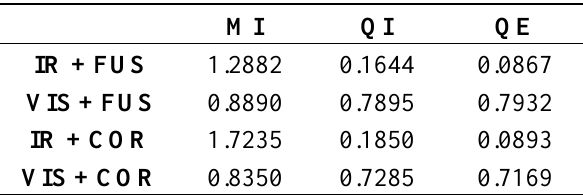
Table 2. Quantitative analysis of IR and VIS image fusion and physical correction. The satellite data were collected on 1300 LST 26 July